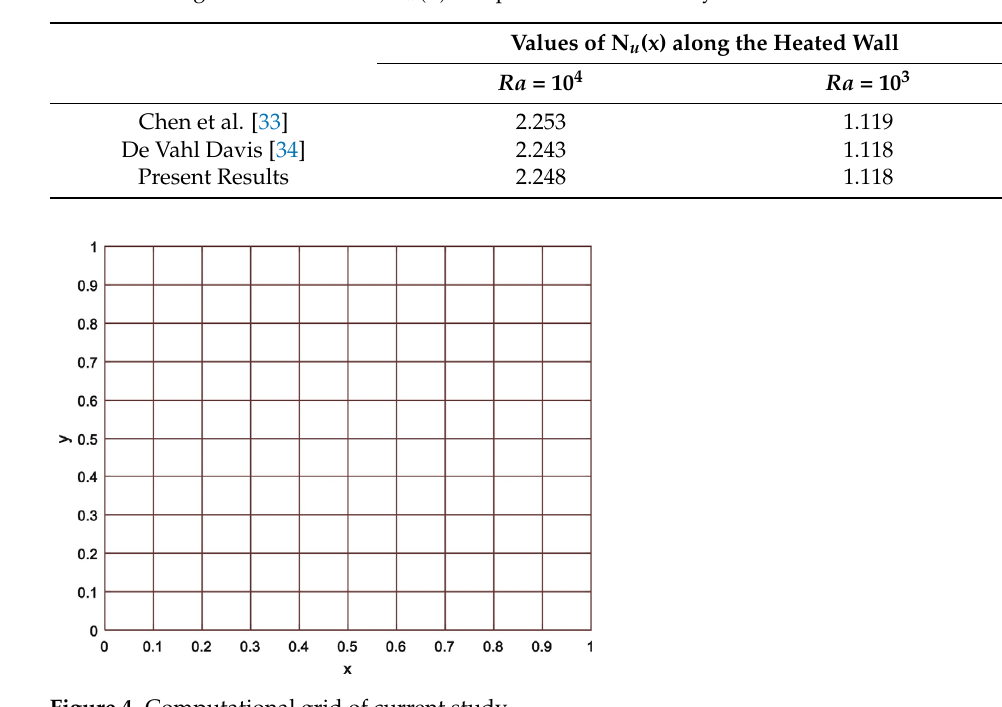
Figure 4. Computational grid of current study.